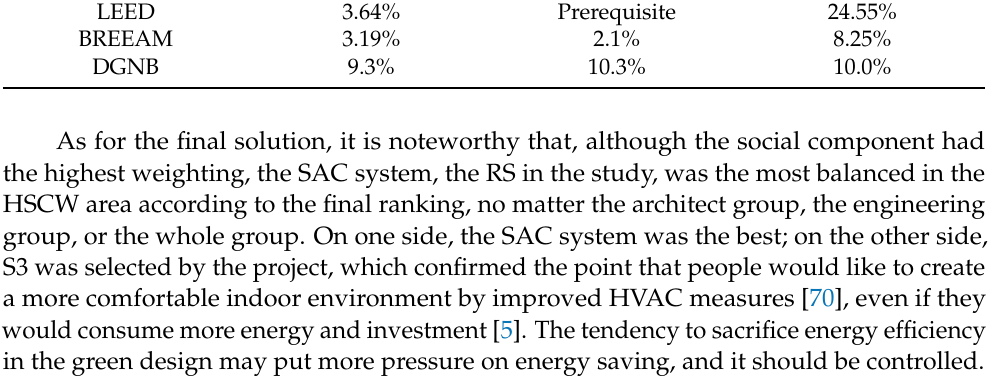
Table 12. The proportions of the three categories for HVAC systems. Systems Social Economic Environmental ATI (all) 39.0%